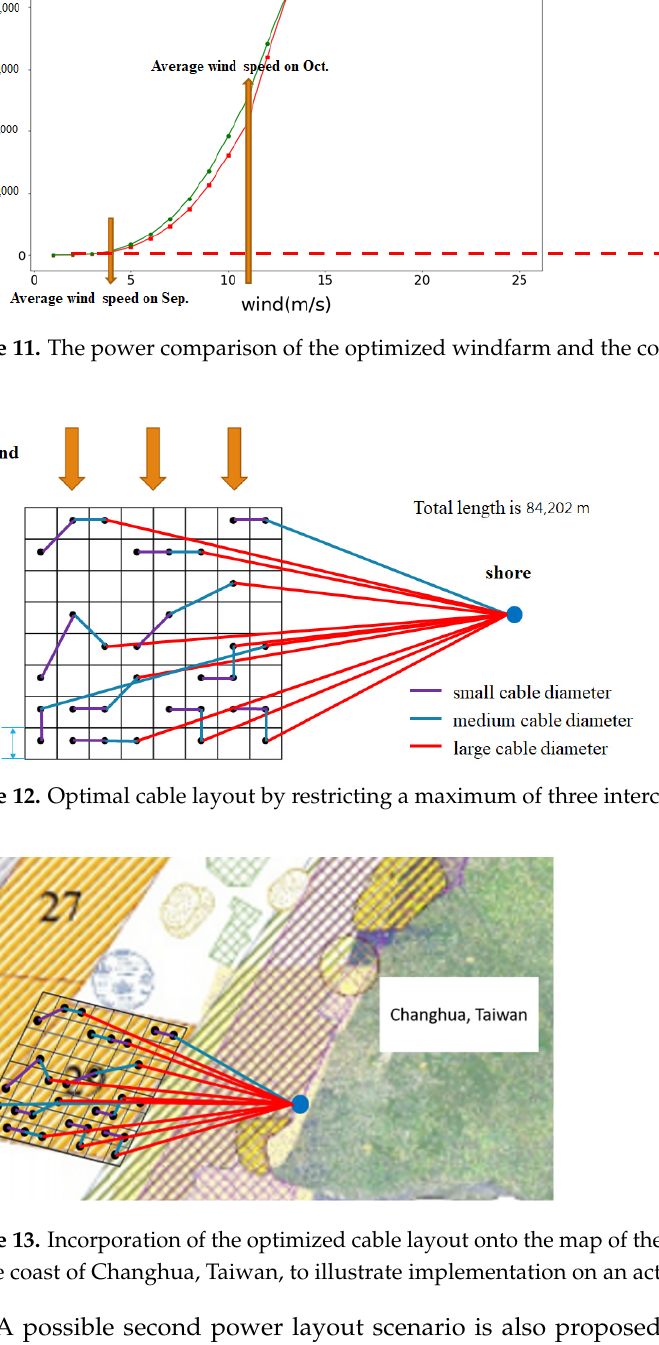
Figure 13. Incorporation of the optimized cable layout onto the map of the planned No. 29 windfarm off the coast of Changhua, Taiwan, to illustrate implementation on an actual site. A possible second power layout scenario is also proposed by grouping into four sub- station groups. The major station is associated with four substation groups. Therefore, the second turbine layout constraint is limited to four substation groups. Using this cabling